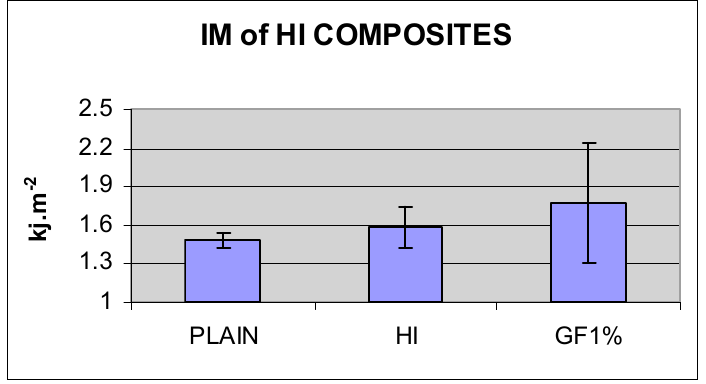
Figure 17. Impact strength of plain acrylic denture base resin, high-impact denture base resin and its composite with acrylic coated glass flakes.